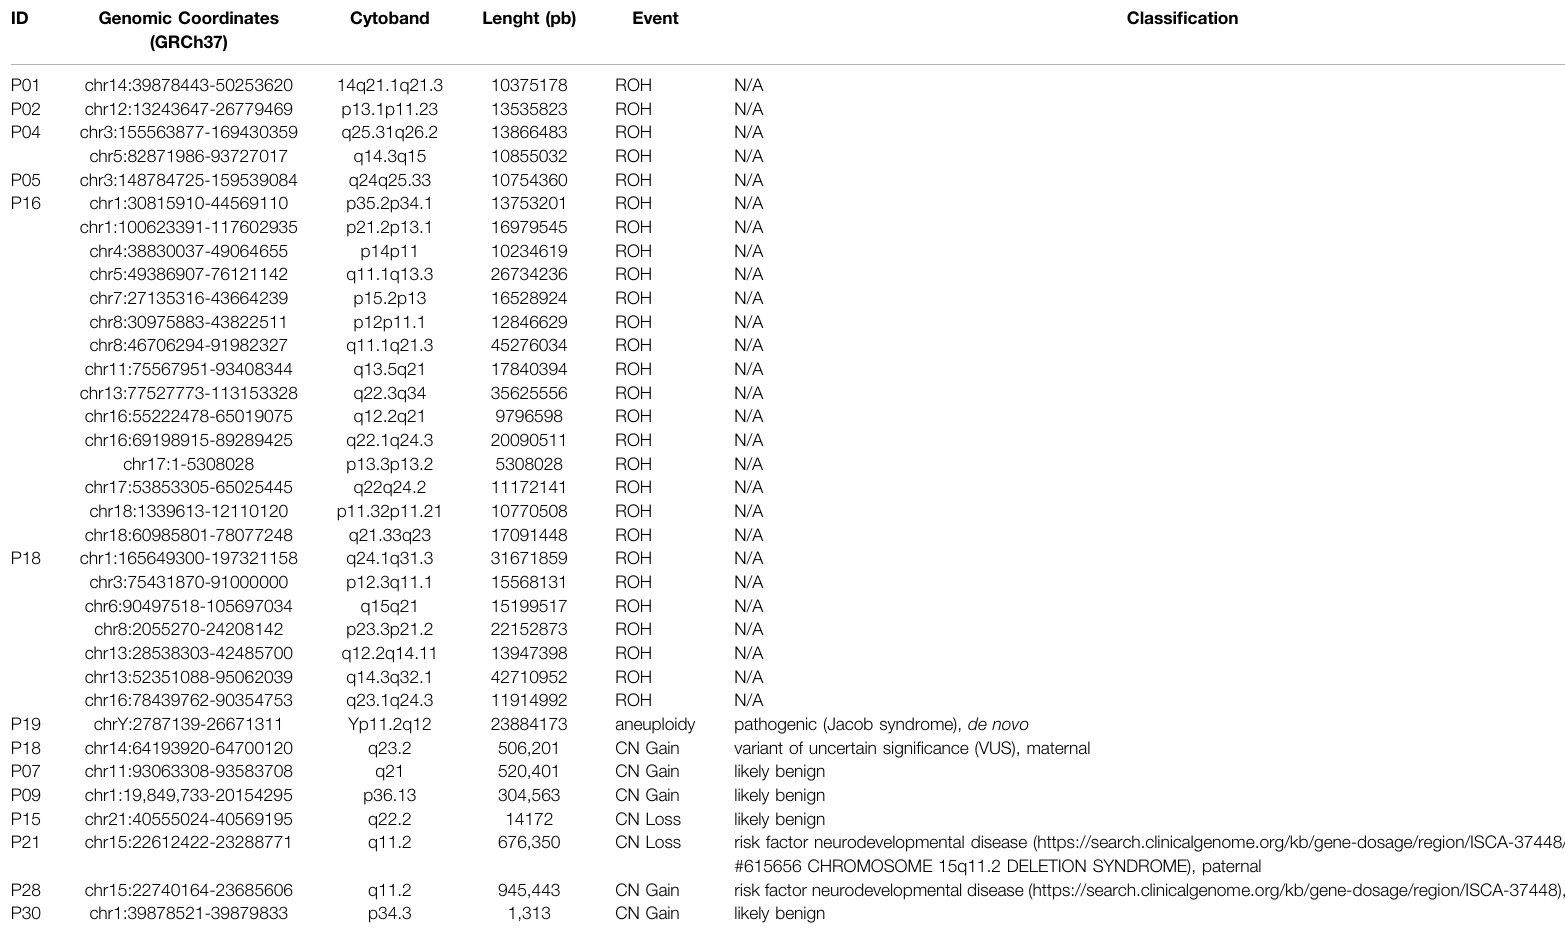
ROH: copy-neutral region of homozigozity; N/A: not